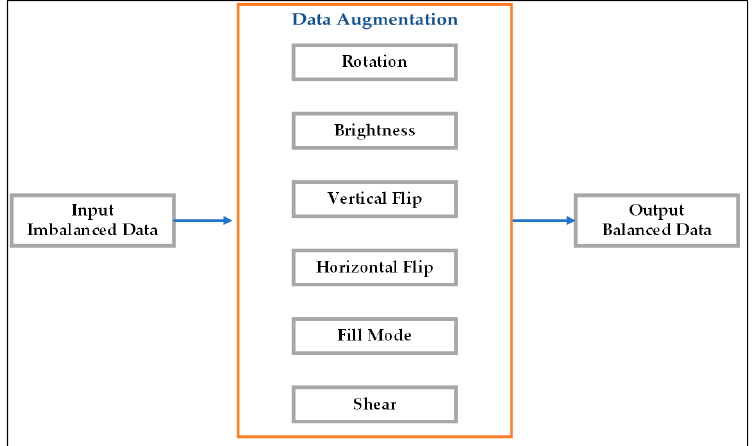
Figure 8. Data augmentation process.